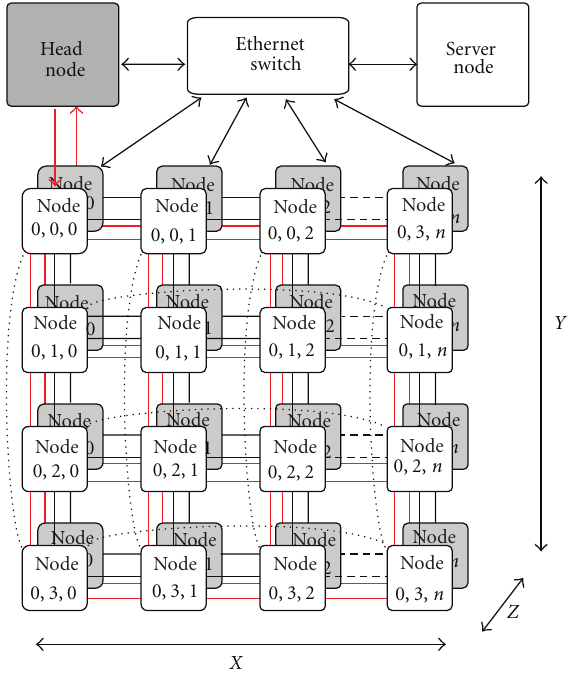
Figure 3: Block diagram of Spirit cluster’s